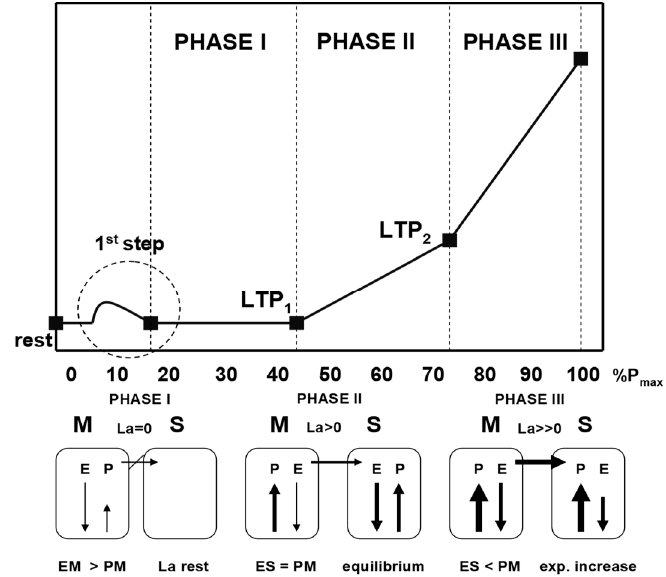
Figure 1. Time course of blood lactate concentration (La) during an incremental cycle ergometer test and the lactate shuttle mechanisms (modified from Tschakert and Hofmann [20]). M—muscle; S—system; P—lactate production; E—lactate elimination; EM—muscular elimination; PM—muscular production; ES—systemic elimination.